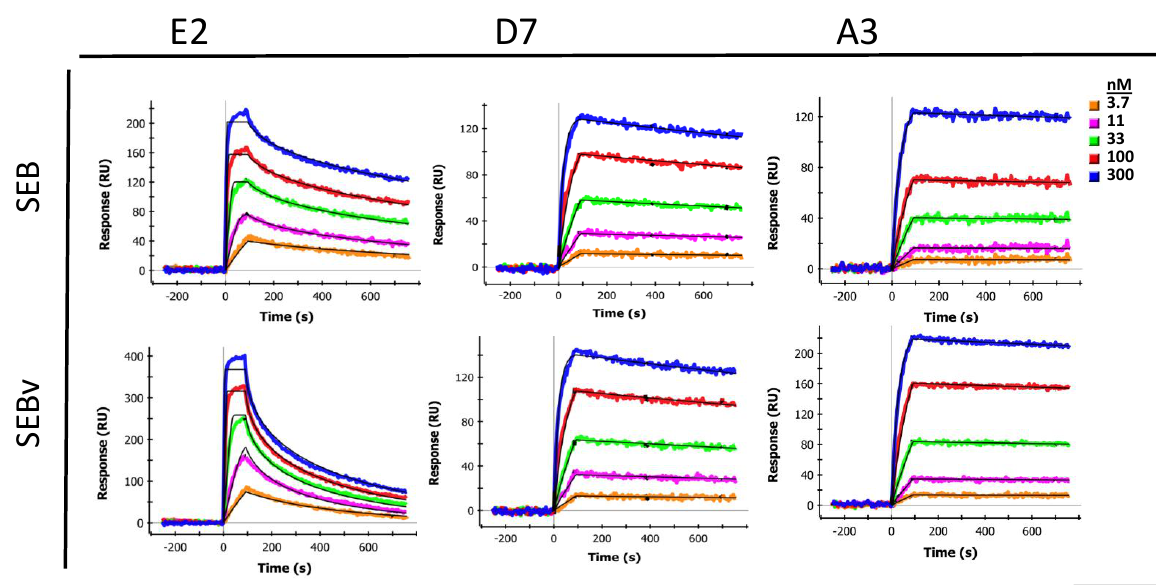
Figure 3. SPR traces for binding of sdAbs E2, D7, and A3 to immobilized SEB and SEBv. SEB and SEBv were immobilized onto gold SPR chip and sdAbs were flowed across chip at concentrations